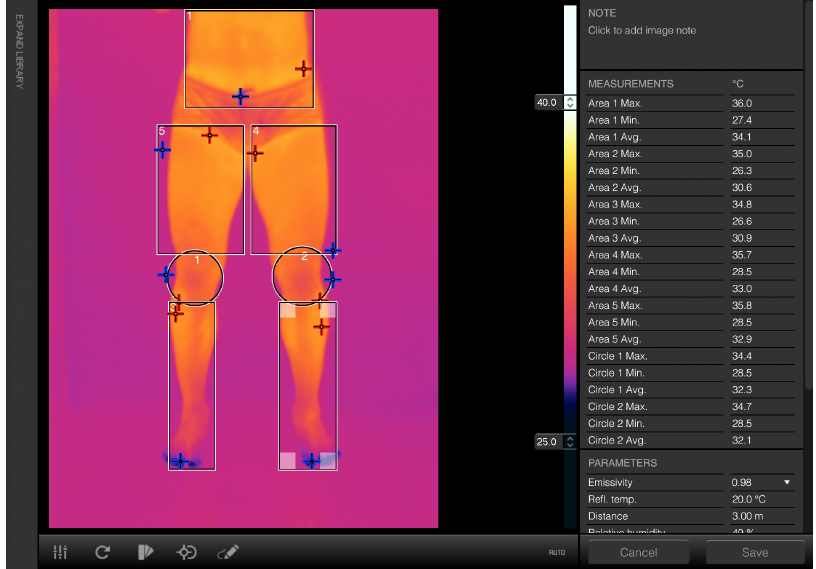
Figure 1. Screen shot of currently available thermal-analysis software. The selection of regions of interest (ROIs) is limited to simple rectangular and elliptical shapes. No functions are available for automatically segmenting the main subject from the background or processing sequences of images taken in distinct